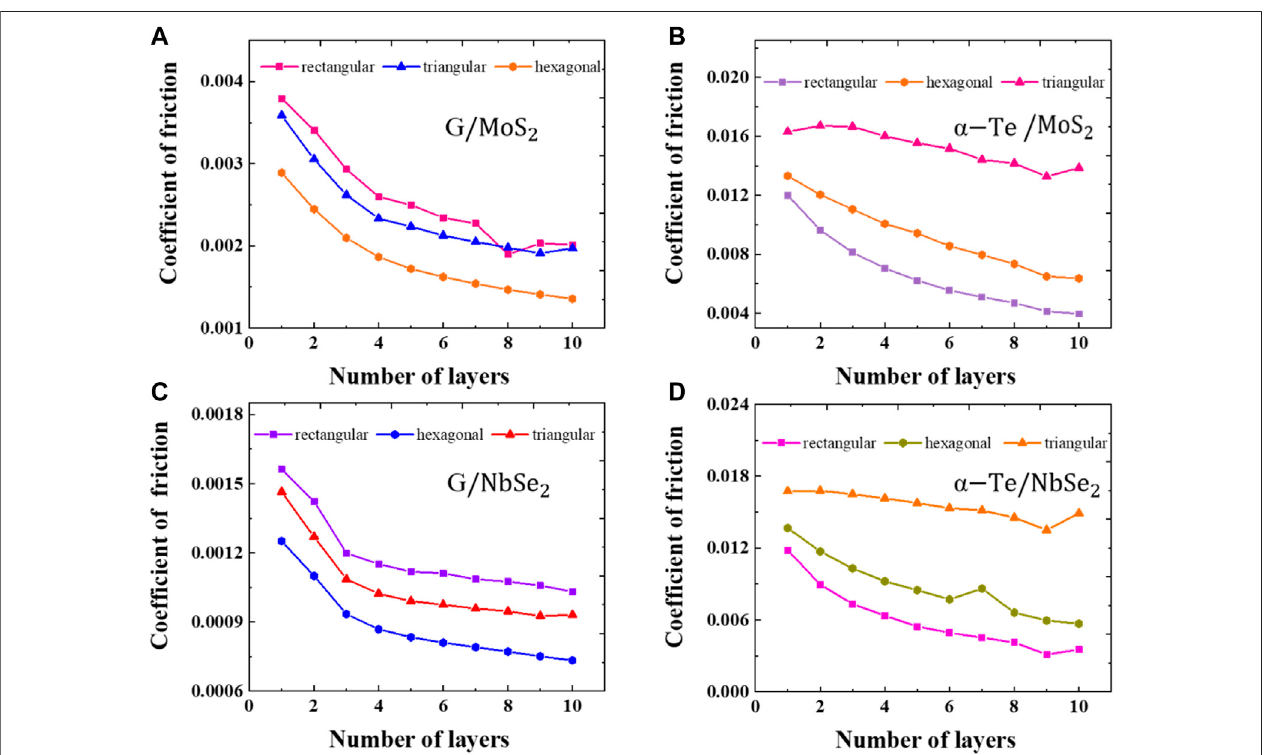
FIGURE 11 | Effect of the number of graphene layers on interlayer friction. (A) graphene/MoS 2 heterostructure; (B) graphene/NbSe 2 heterostructure. (C) α -Te/ MoS 2 heterostructure; (D) α -Te/NbSe 2 heterostructure. The shape of the data points represents the shape of the slider in the MD simulation, which are rectangular, triangular, and hexagonal.